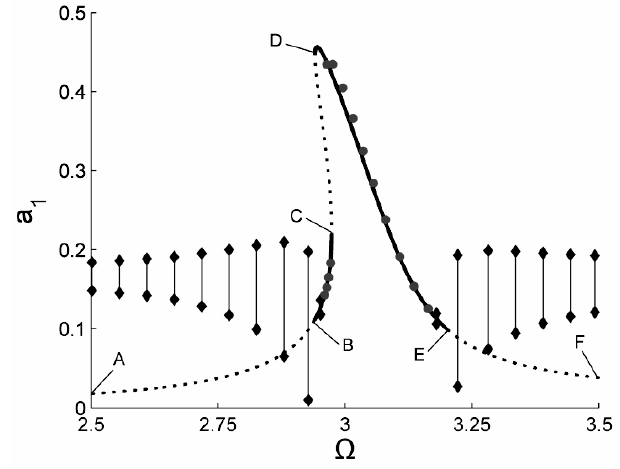
Fig. 2. Analytical and numerical results for the system without control. Analytical solution: solid line – stable solution, dotted line – unstable solution. Numerical simulation: circles – amplitude of periodic motion, diamonds – maximum and minimum amplitude of positive part of envelope of quasi-periodic motion; x 0 =